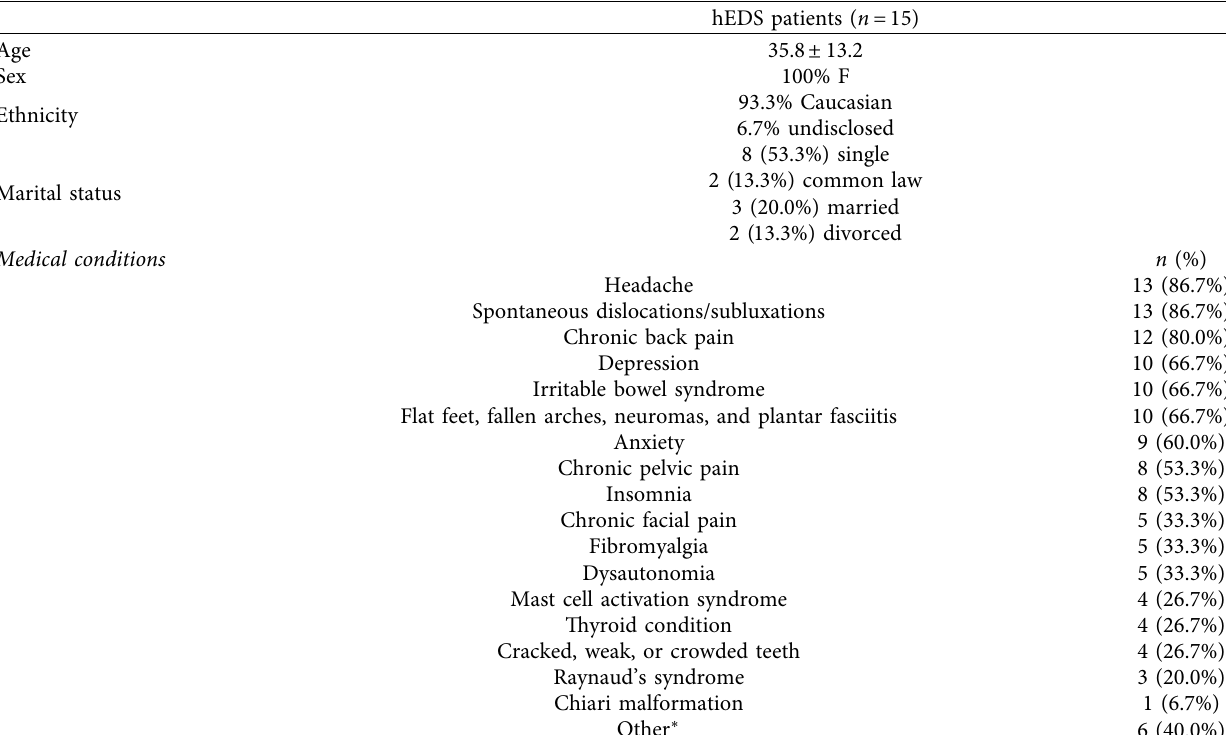
Table 1: Patient